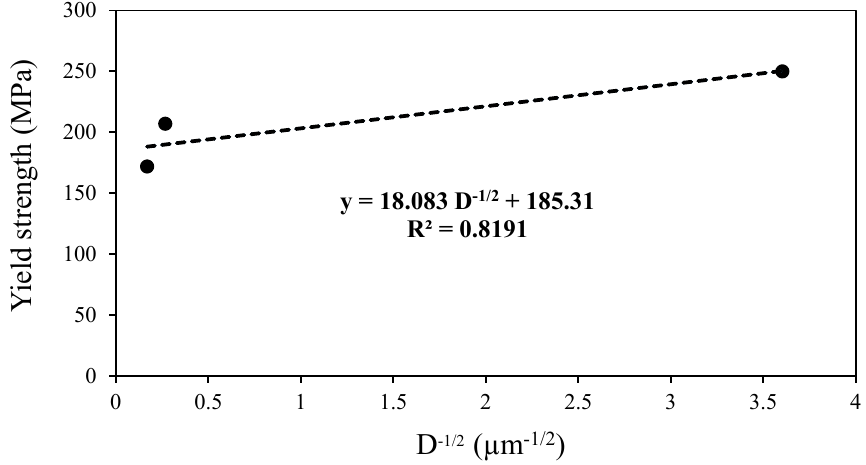
Figure 11. Variations of the yield strength vs. the reciprocal square root of the grain size D -1/2 (D is the